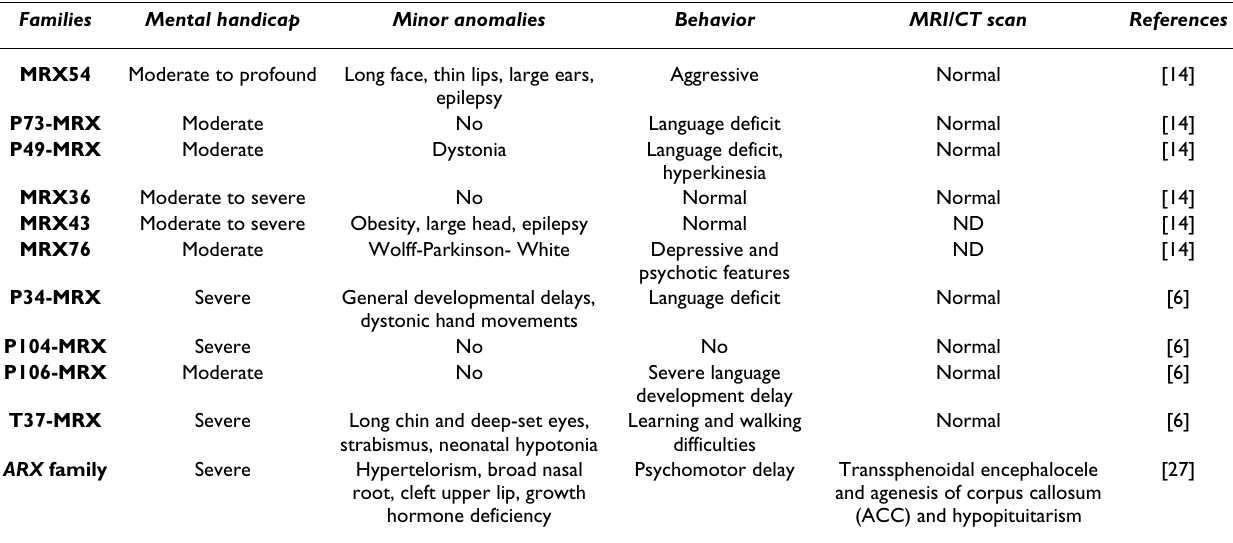
Table 3: Summary of clinical data observed in other ARX dup24 families